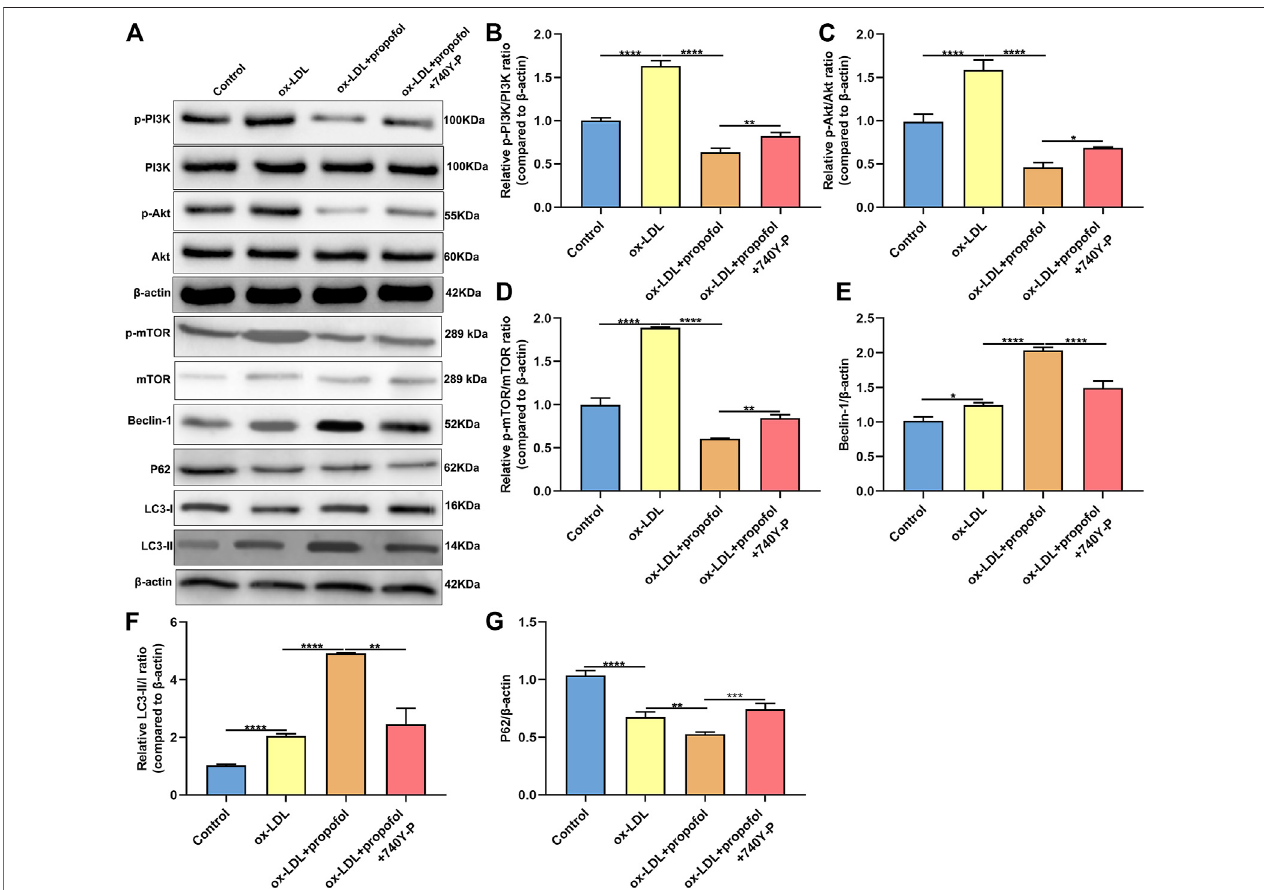
FIGURE6| PropofolboostsautophagyviainhibitingPI3K/Akt/m-TORpathwayinox-LDL-inducedHUVECs. (A) Representativeimagesofwesternblotforp-PI3K, PI3K, p-Akt,Akt, p-mTOR, mTOR, Beclin-1, P62, LC3-I and LC3-II in100 ° μ g/mlox-LDL-exposed HUVECs treated with100 ° μ M Propofol and /or 100 ° μ M 740Y-P. The quanti fi cationof (B) p-PI3K/PI3Kratio, (C) p-Akt/Aktratio, (D) p-mTOR/mTORratio, (E) Beclin-1, (F) LC3-II/LC3-Iratioand (G) P62expressionbasedonthewestern blot results. * p < 0.05; ** p < 0.01; *** p < 0.001 and **** p < 0.0001.